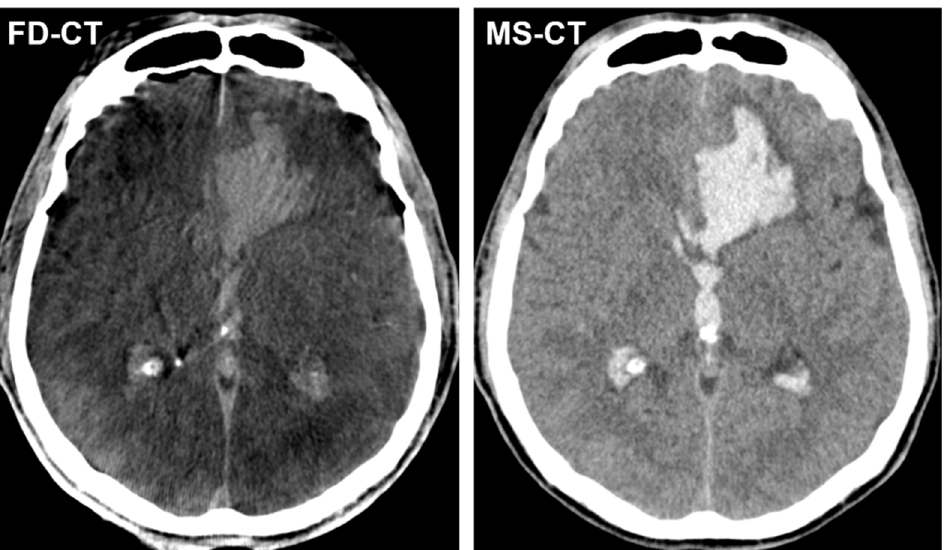
Figure 2. Exemplary FD-CT and MS-CT images of a patient with an endovascular treated, aneurysmal SAH and accompanying atypical intracerebral haemorrhage (ICH) in the left frontal lobe as well as intraventricular haemorrhage (IVH) in both lateral ventricles and the third ventricle. Both FD-CT and MS-CT allow equal delineation of ICH and IVH.